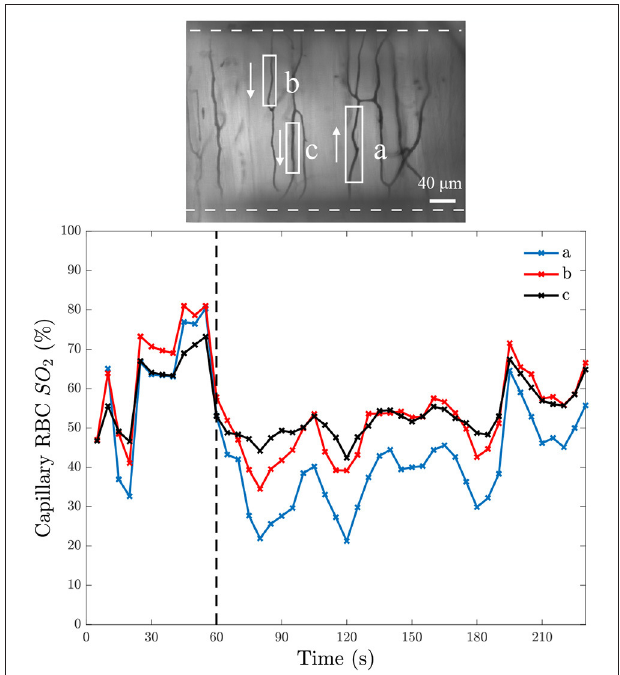
FIGURE 7 | (Bottom) Distribution of the average capillary red blood cell oxygen saturation (Capillary RBC SO 2 ) binned into 5-s intervals in response to three window O 2 levels: 2% (orange), 5% (blue), and 12% (red). Histogram bins are partially transparent to show the overlap. The minimum intensity functional image of the analyzed field of view is given above the histogram (Top) ; the analyzed capillaries are indicated with white